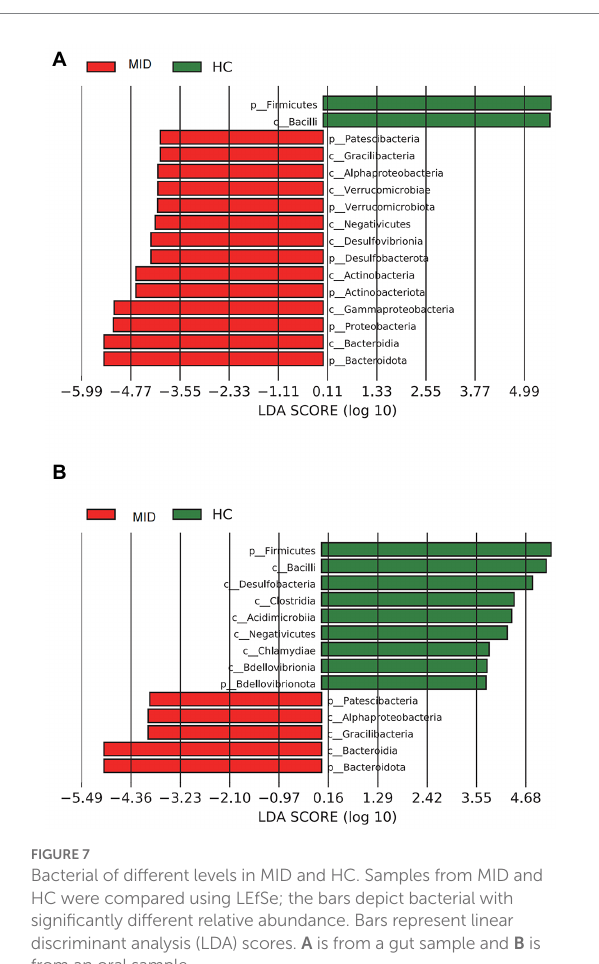
FIGURE 7 Bacterial of different levels in MID and HC. Samples from MID and HC were compared using LEfSe; the bars depict bacterial with significantly different relative abundance. Bars represent linear discriminant analysis (LDA) scores. A is from a gut sample and B is from an oral